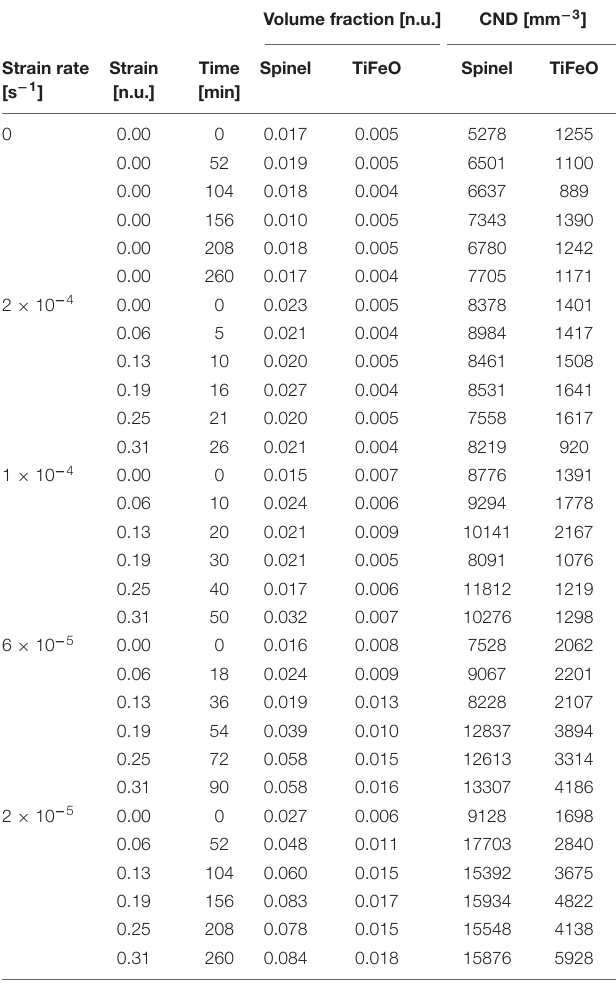
TABLE 2 | Summary of the experiments.